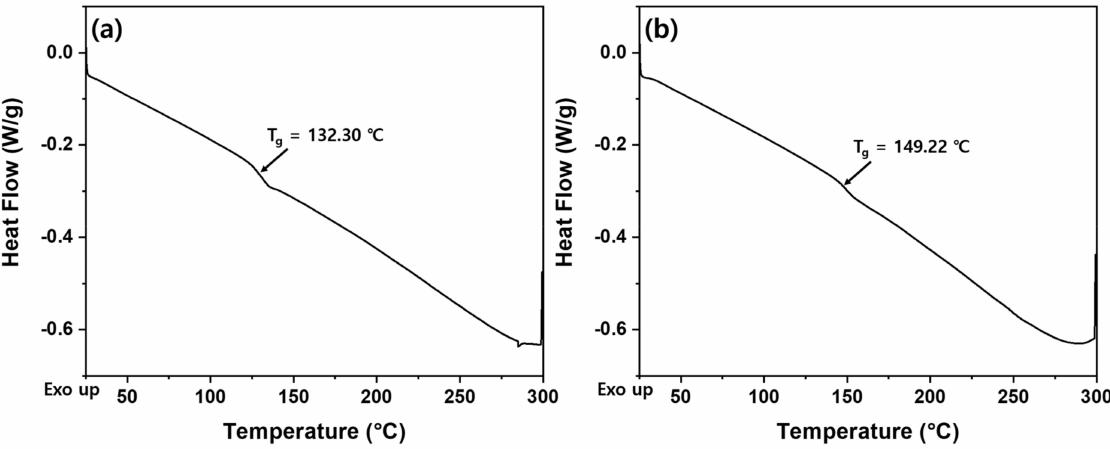
Figure 8. DSC curves of ( a ) PTK and ( b ) PTS.